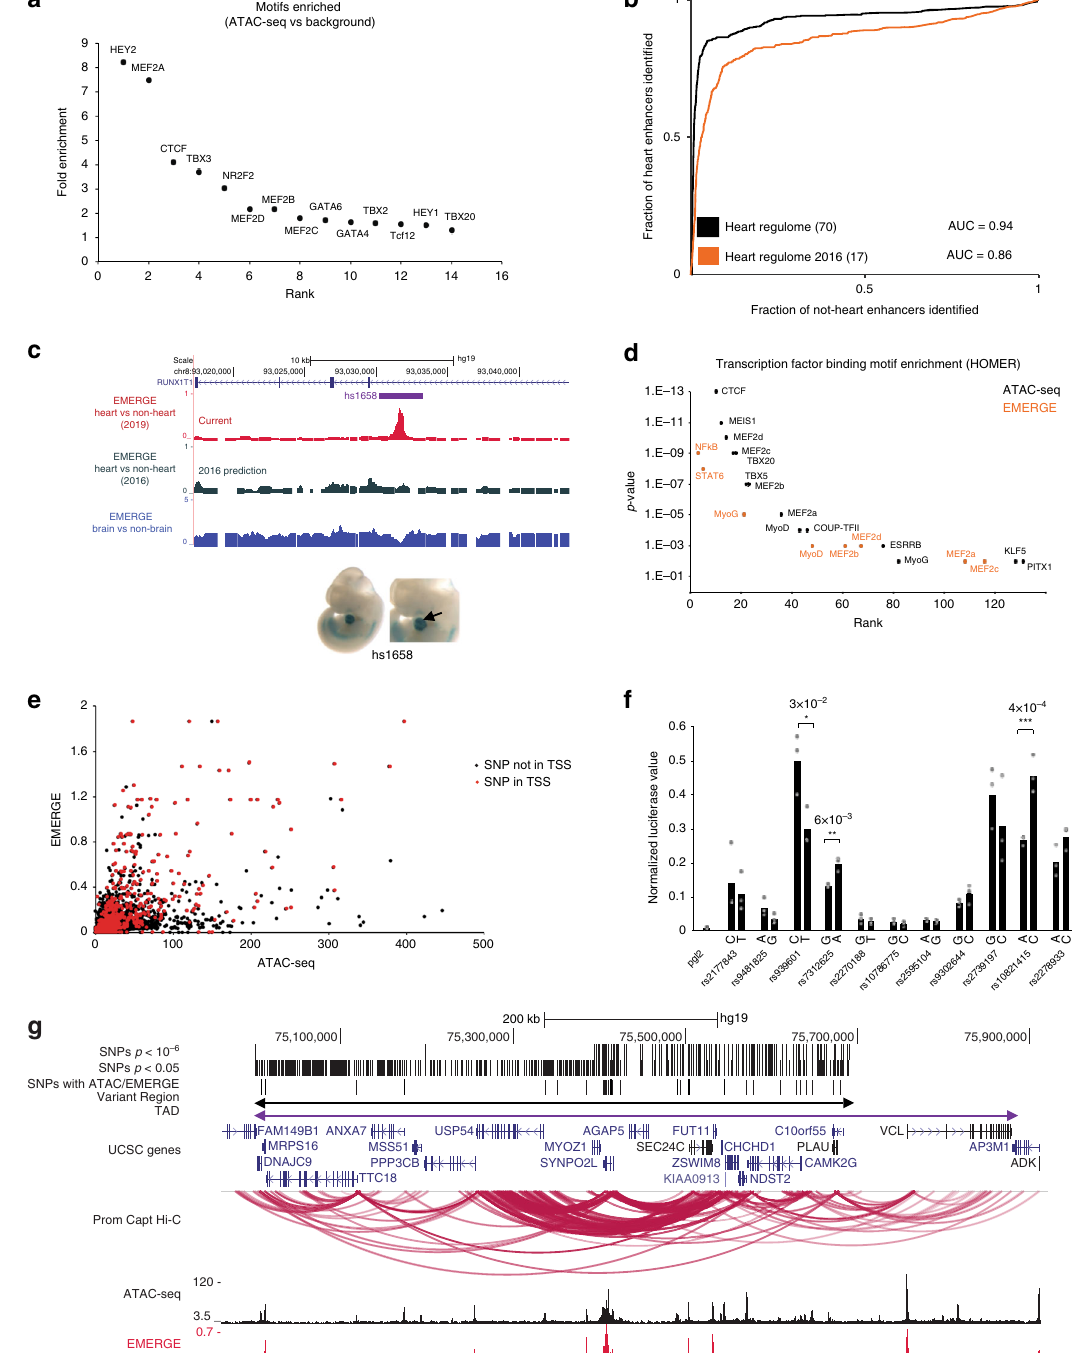
Fig. 6 Identi fi cation of cardiac regulatory elements and functional AF-associated non-coding variants. a ATAC-seq motif enrichment, b Area under the receiver operating characteristic curves showing the improved prediction of the revised EMERGE, c Browser view of human heart enhancer prediction for brain, previous heart prediction 38 and current heart prediction. hs1658 drives LacZ expression in the heart in the mouse embryo (Vista enhancer browser). d HOMER motif analysis on peak-calling ATAC-seq, EMERGE and overlapping peaks. e ATAC-seq and EMERGE peaks overlapping known AF GWAS variants, as well as variants that lie in promoters (red). f Allele-speci fi c luciferase assay performed in iAM-1 cells. Error bars represent SD, * p < 0.05, ** p < 0.01, and *** p < 0.001 (two-tailed Student ’ s t -test). Source data are provided as Source Data fi le. g SYNPO2L locus with GWAS variants, PCHi-C, ATAC- seq and EMERGE tracks. PCHi-C promoter capture Hi-C, ATAC-seq assay for transposase-accessible chromatin